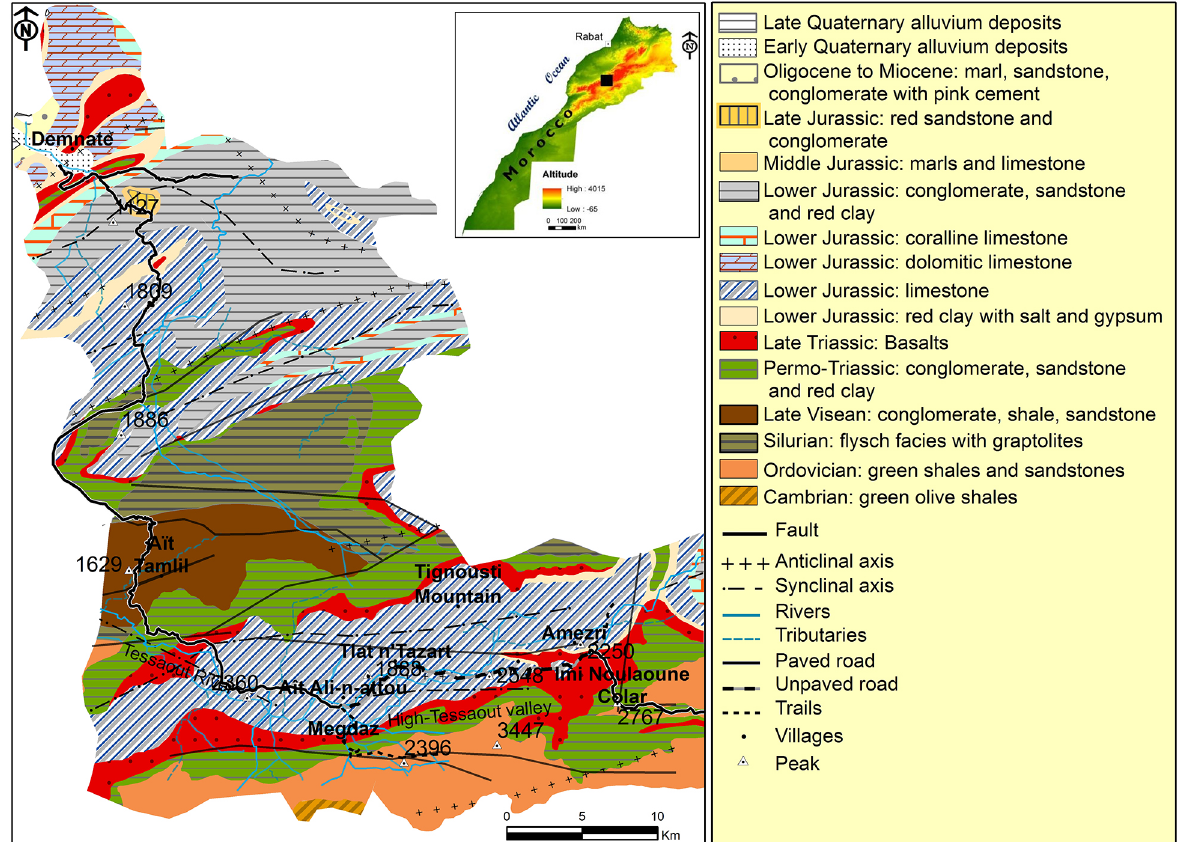
Fig. 1. Geographical location and geological map of the study area (acc. to Roch